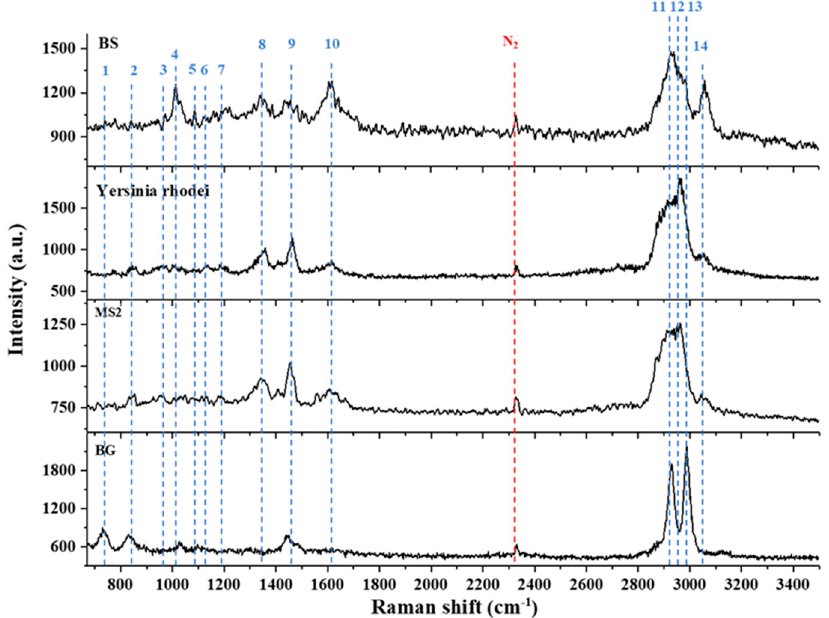
Figure 6. Raman spectra of BWA surrogates. (Reproduced with permission from ref. [8]. Copyright 2021, IOP science).